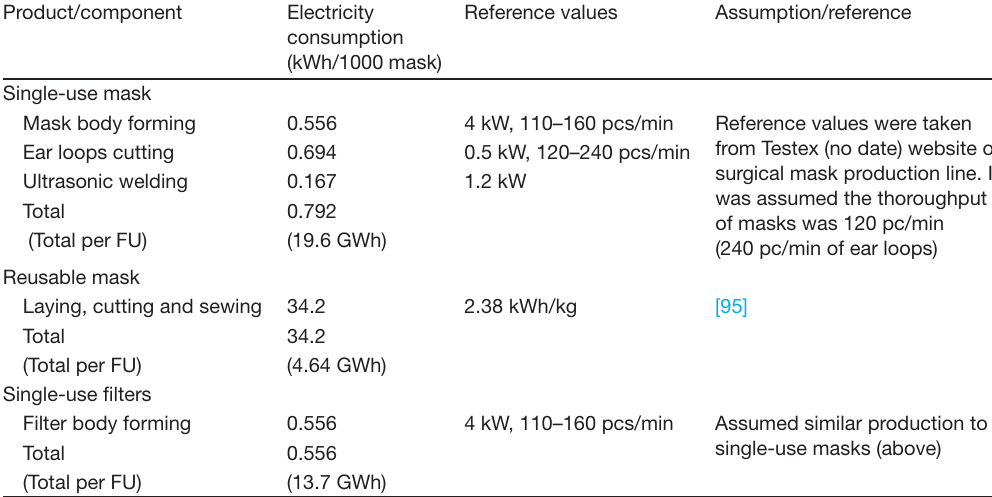
Table A5. Electricity assumptions for the manufacture of masks and